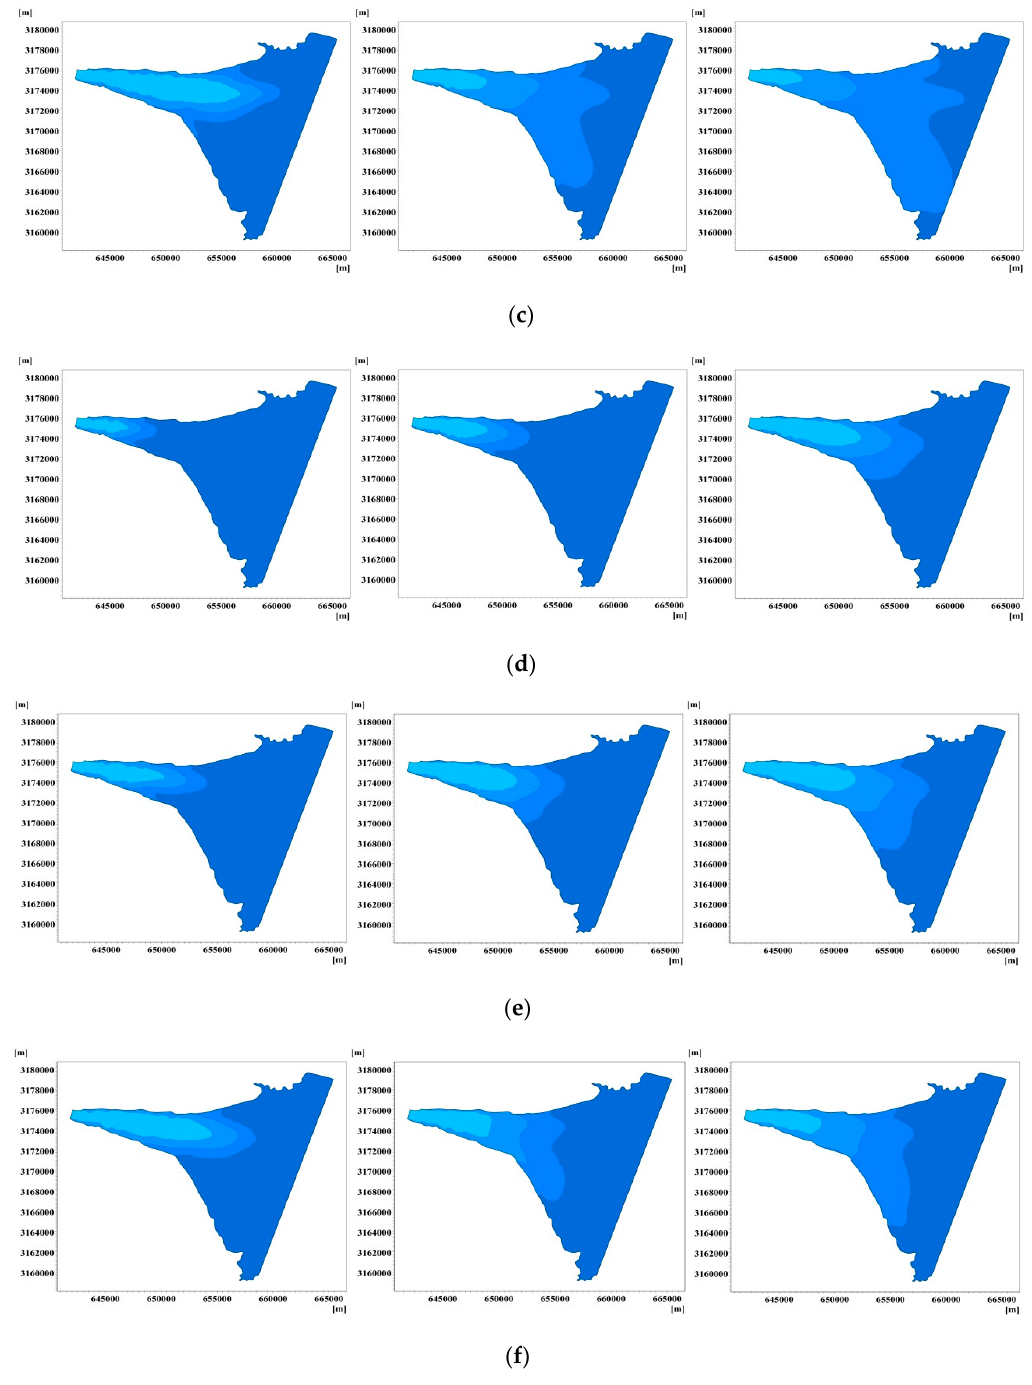
Figure 8. Distribution diagram of salinity sluice at three times of low tide after the opening of estuarine sluice. ( a ) Discharged with flow of 1500 m 3 / s during spring tide; ( b ) discharged with flow of 3000 m 3 / s during spring tide; ( c ) discharged with flow of 5000 m 3 / s during spring tide; ( d ) discharged with flow of 1500 m 3 / s during neap tide; ( e ) discharged with flow of 3000 m 3 / s during neap tide; ( f ) discharged with flow of 5000 m 3 / s during neap